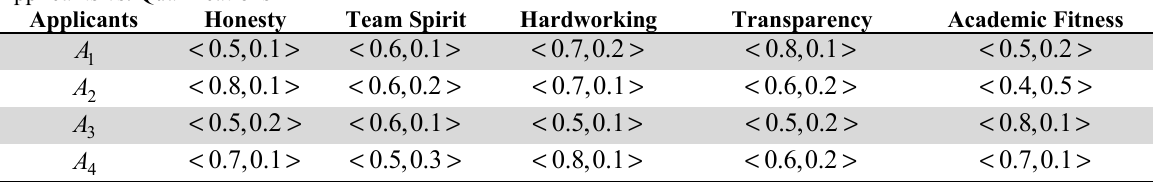
Applicants vs. Qualifications